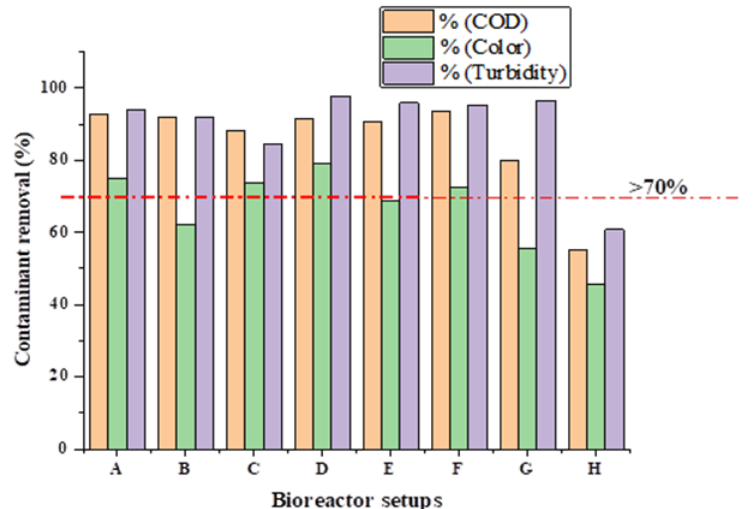
Figure 2. Contaminant removal for bioreactors A (mF), B (NmF), C (CmF), D (TmF), E (ChTmF), F (CTmF), G (ATmF), and H (no MNM) of MNM loading of 1.5 g at 35 °C for 30 HRT.